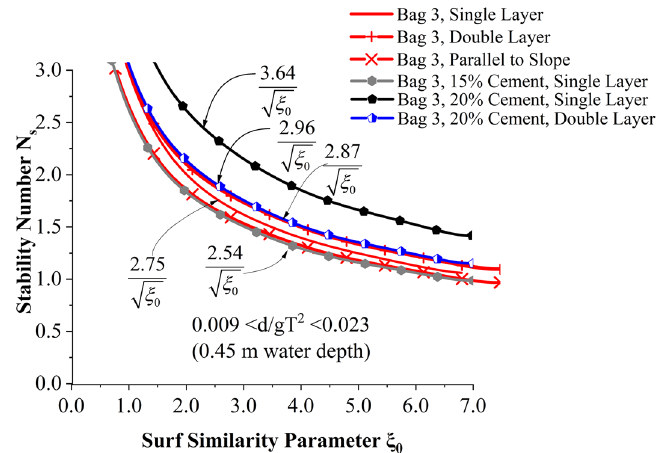
Figure 21. Stability curves for Bag 3 with all the tested